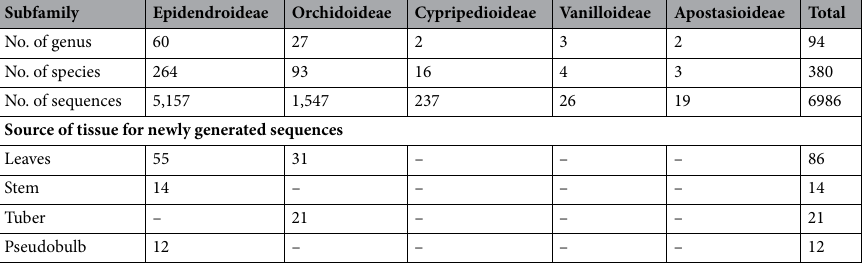
Table 1. Summary of taxon sampling in this study.